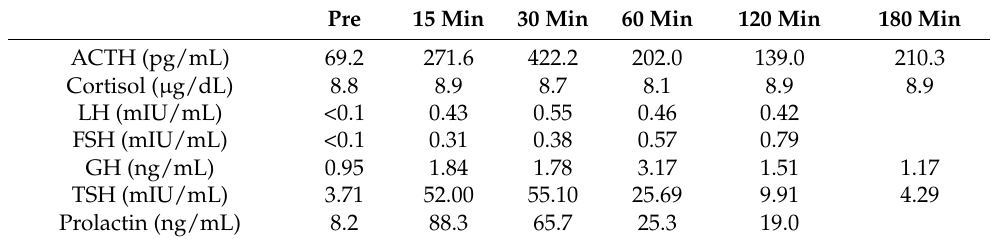
Table 2. CRH, LHRH, GRH and TRH load test.